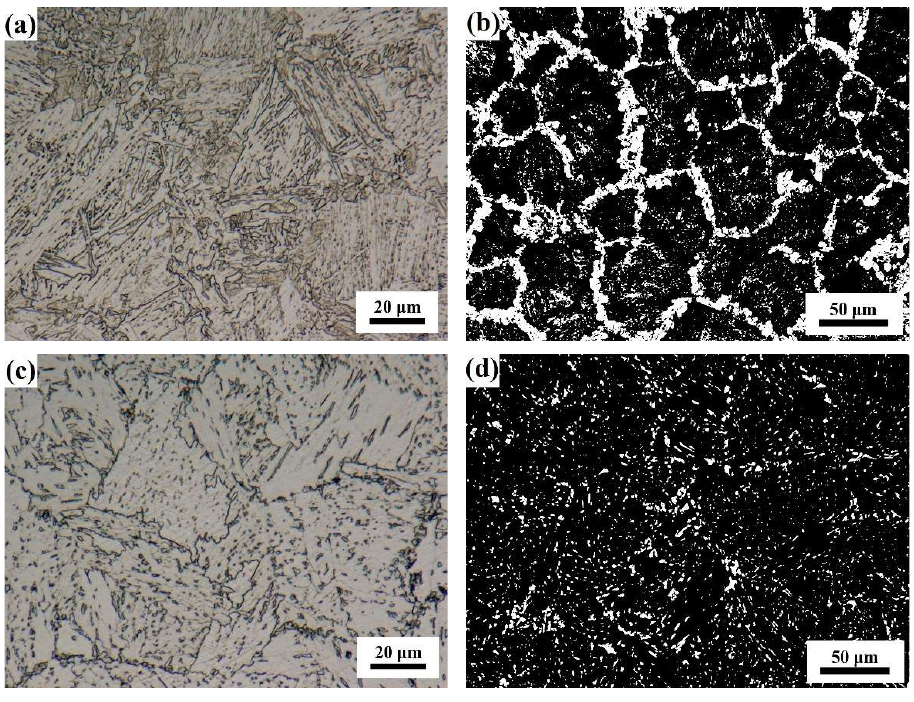
Figure 6. Microstructure and M/A constituents of the simulated ICCGHAZs with different cooling rates: ( a , b ) ICCGHAZ-4 and ( c , d ) ICCGHAZ-5.